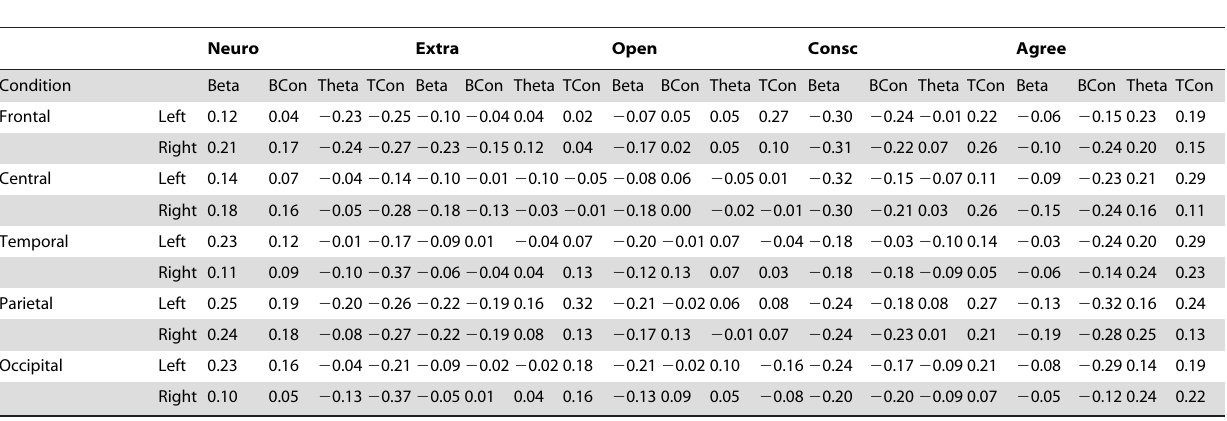
Table 7. Correlations of Beta, Theta Experimental and Control Frequency Binaural Beat Cortical Powers in Divided Cortical Areas and NEO Personality